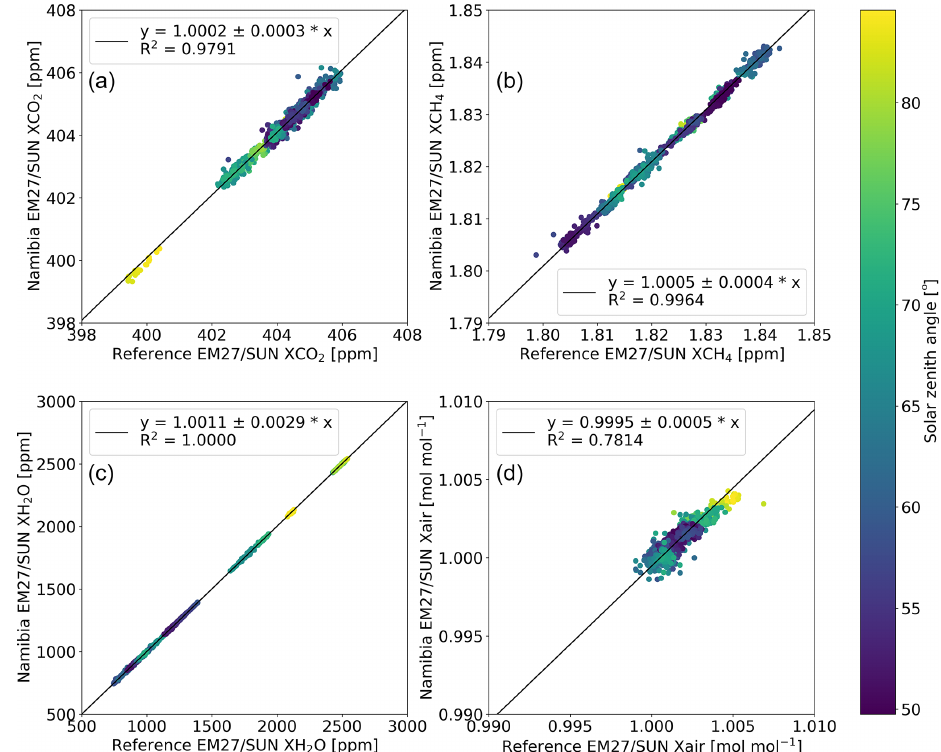
Figure 4. Side-by-side measurements between the reference EM27/SUN and the instrument deployed in Namibia performed between November 2015 and March 2016 in Karlsruhe. From left to right, the panels show correlation plots for XCO 2 (a) , XCH 4 (b) , XH 2 O (c) and X air (d) . The coincident criterion is that measurements for both instruments occurred within 1min. The color bar denotes the solar zenith angle. For the analysis, only measurements with zenith angles below 85 ◦ are